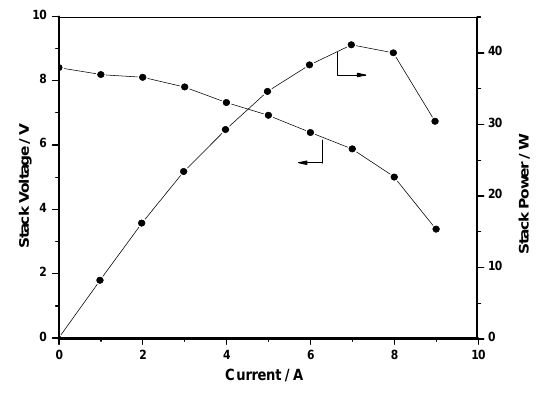
Figure 6. Polarization data for the DBFC